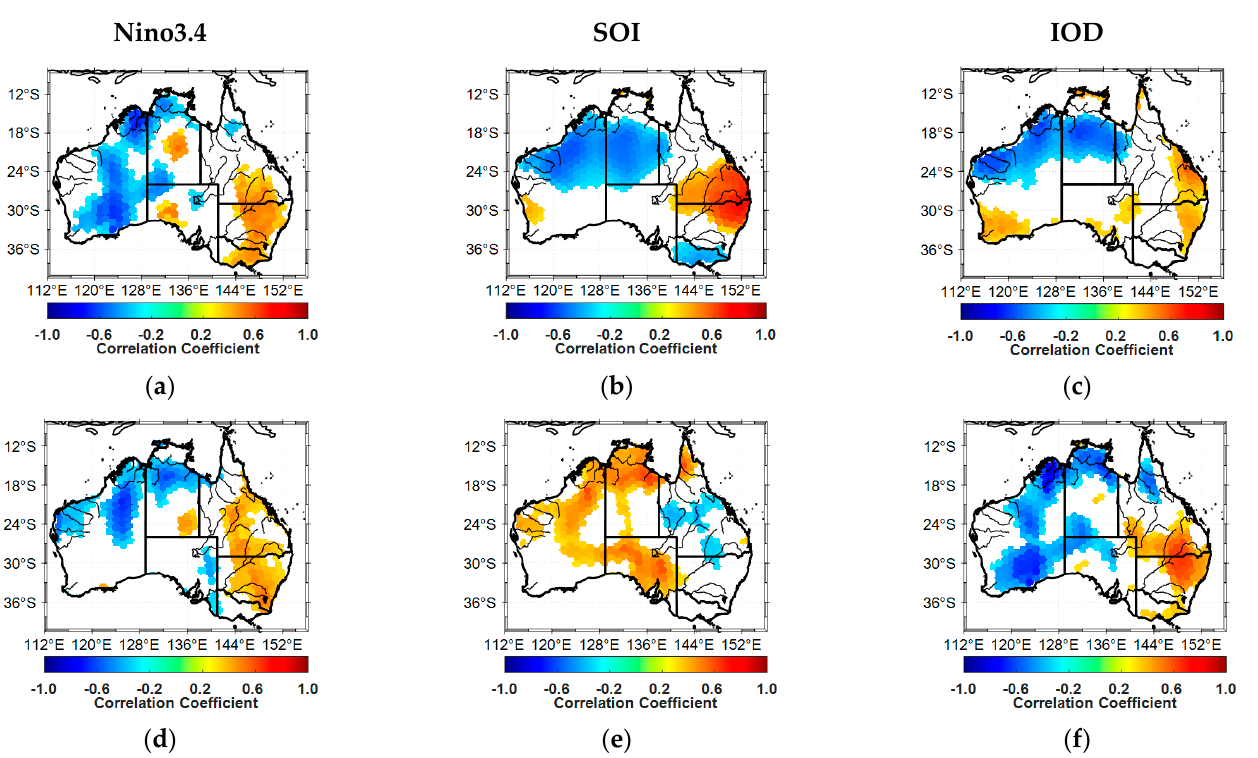
Figure 9. The correlation coefficients between TSDI and drought driving factors. Upper: Drought 2006–2009; bottom: Drought 2018–2020. ( a , d ) represent for Nino3.4; ( b , e ) SOI; ( c , f ) for IOD.